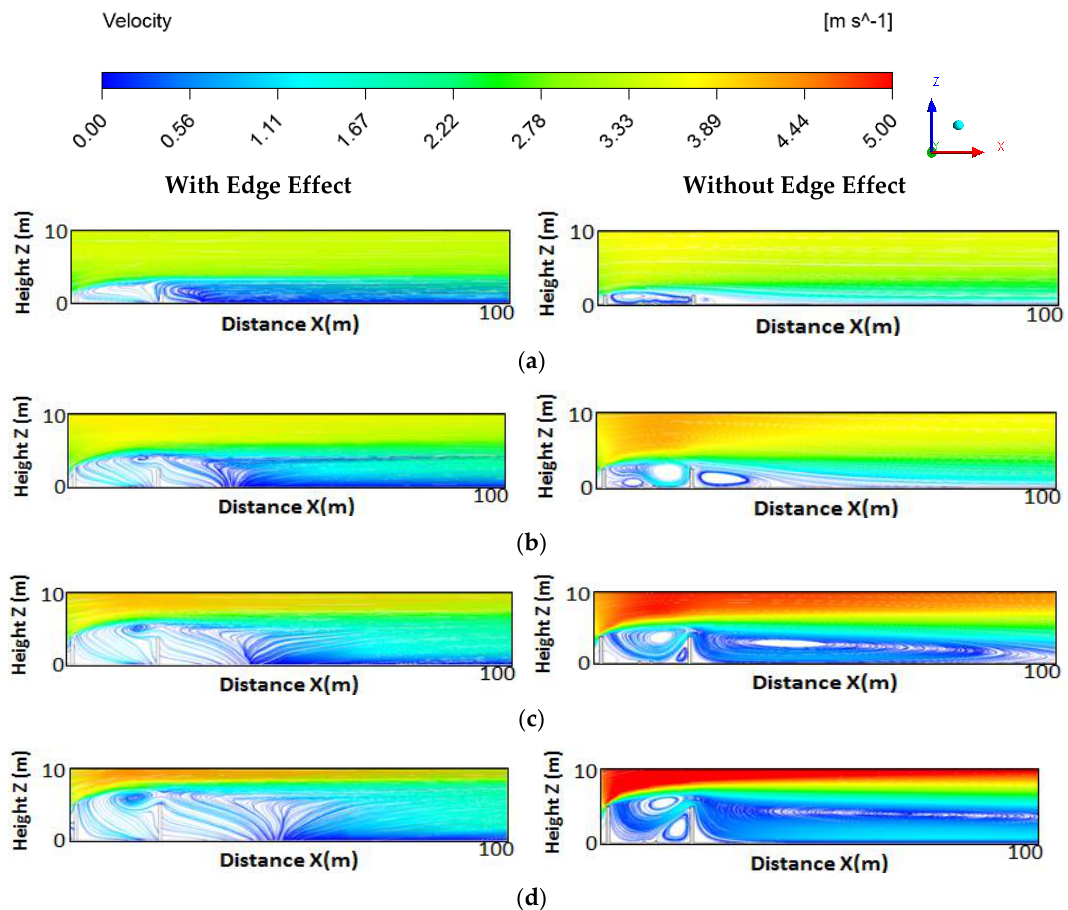
Figure 6. Comparison of streamline in symmetry plane (Y = 90 m) for barrier geometry with and without edge effects at different barrier heights under neutral condition. The noise barrier height is